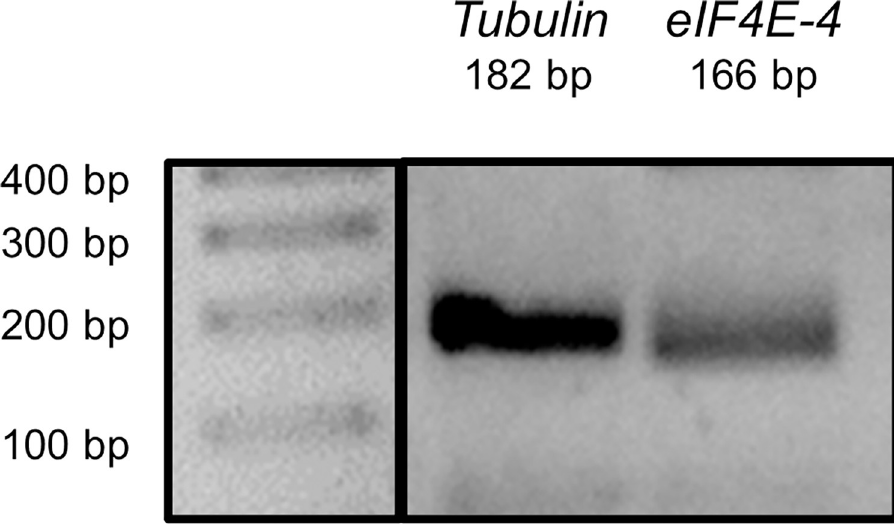
Fig 5. mRNA of eIF4E-4 is expressed in cardiac tissue of Drosophila melanogaster . RT-PCR using specific primers to amplify a fragment of tubulin and of eIF4E-4 was carried out using isolated cardiac tissue. The size of each respective amplicon corresponds to the expected size ( tubulin : 182 bp; eIF4E-4 : 166 bp).